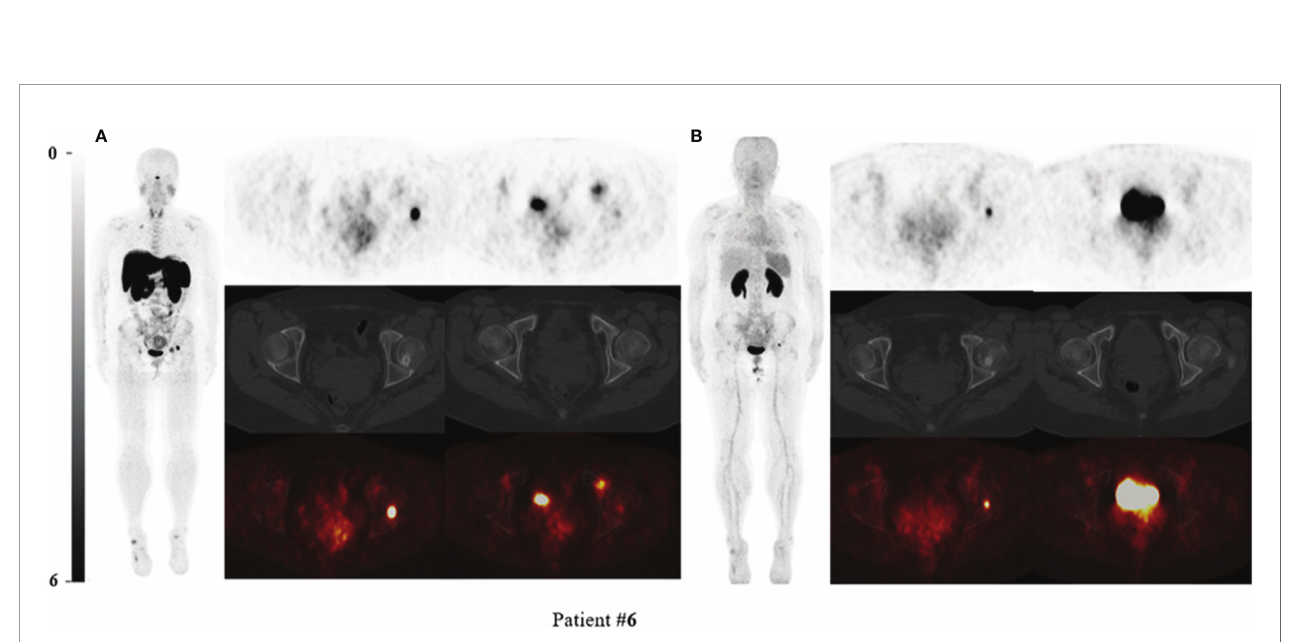
FIGURE 1 | 68 Ga-DOTA-TATE PET/CT comparing with 68 Ga-DOTA-JR11 PET/CT in Patient #7. The causative tumors of TIO were found in the left femoral head in patient #7 (A) on 68 Ga-DOTA-TATE PET/CT, but negative on 68 Ga-DOTA-JR11 PET/CT (B) . The lesion of the left femoral head was con fi rmed as the causative tumor of TIO by postsurgical pathological results.